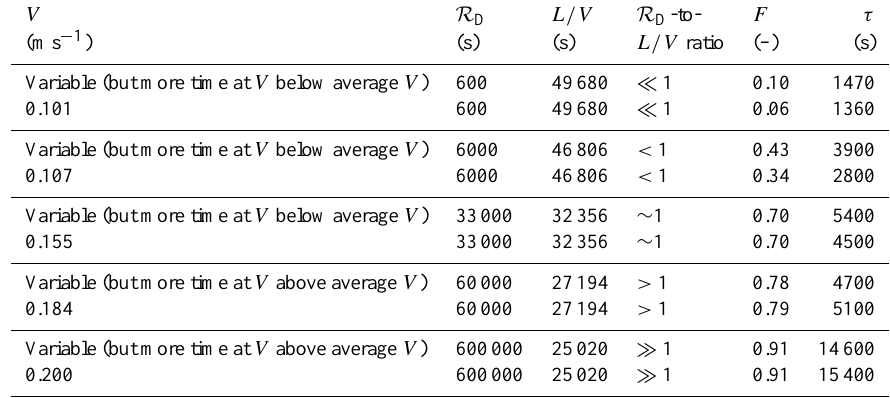
Other parameters different from values in Table 1: L = 5000 m .